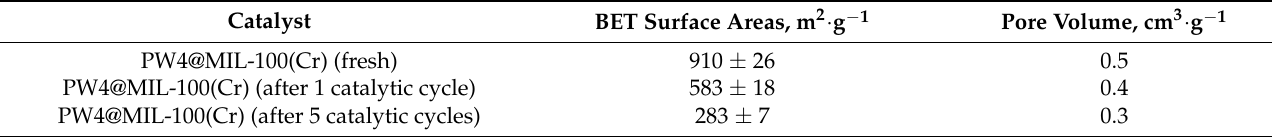
Table 7. Catalyst EDS analysis